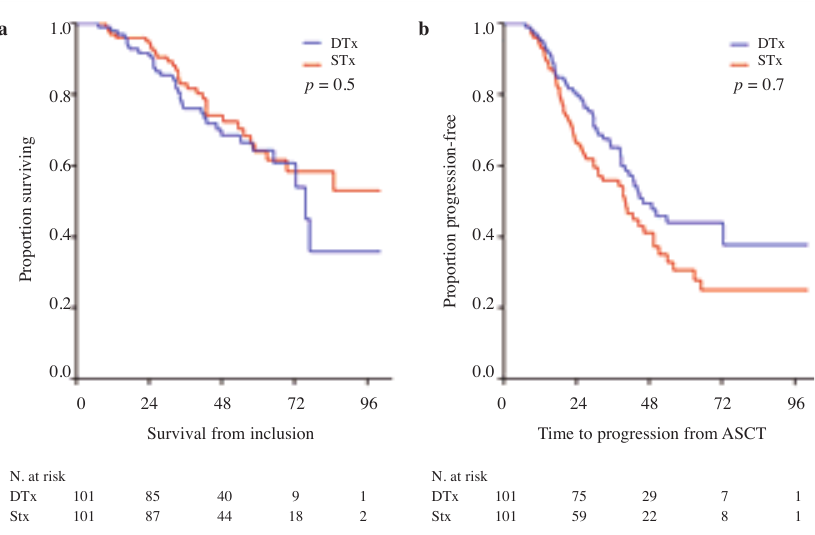
Figure 2. Case control analysis comparing double and single transplantation. Overall sur- vival (a) and progression free survival (b) following double transplantation in trial transplantation. Tables below the graph indicate patients at risk for the